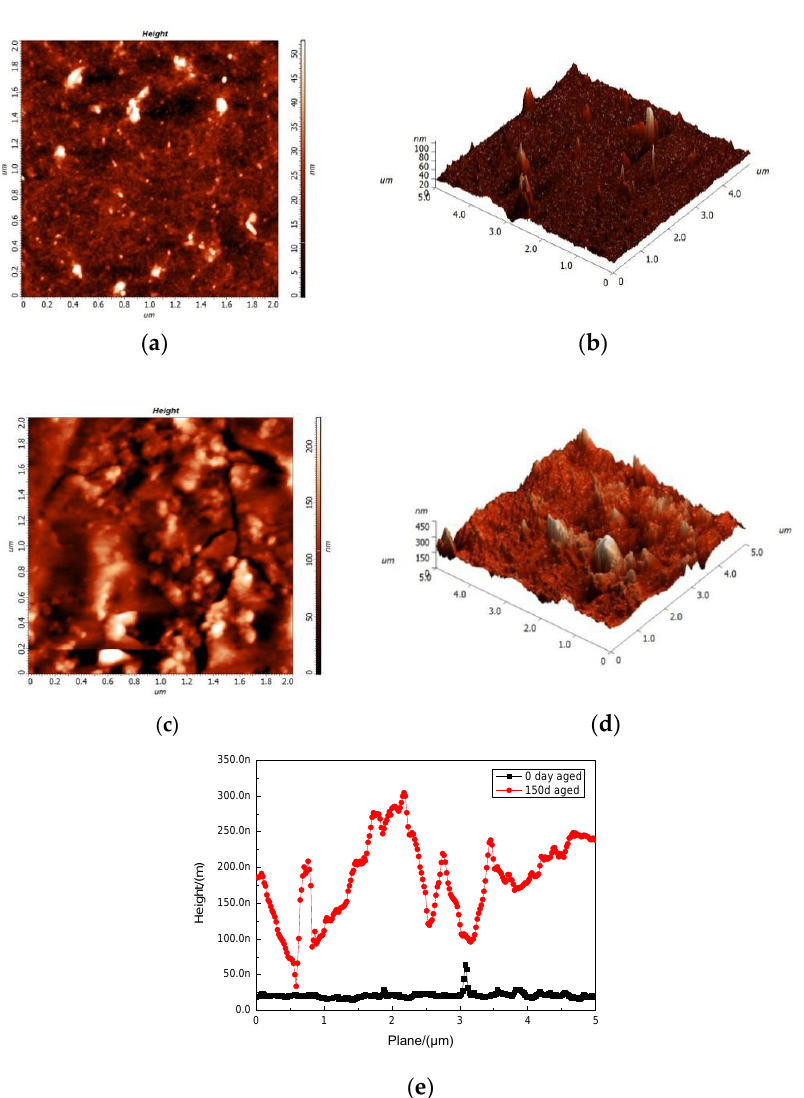
Figure 9. AFM of polyurea coating ( a ) 2D topographic image of PCB; ( b ) 3D topographic image of PCB; ( c ) 2D topographic image of PCA; ( d ) 3D topographic image of PCA; and ( e ) the height of surface before and after 150 d aging.